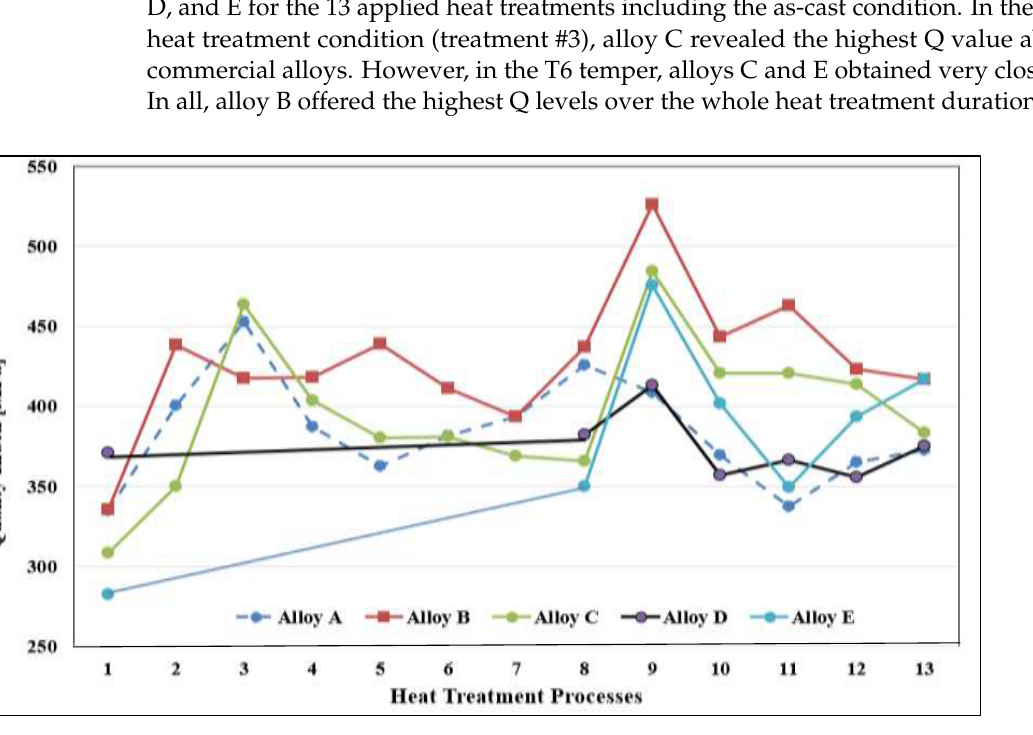
Figure 13. Quality values of alloys A, B, C, D, and E in the as-cast condition and all 13 heat treatment conditions used in this